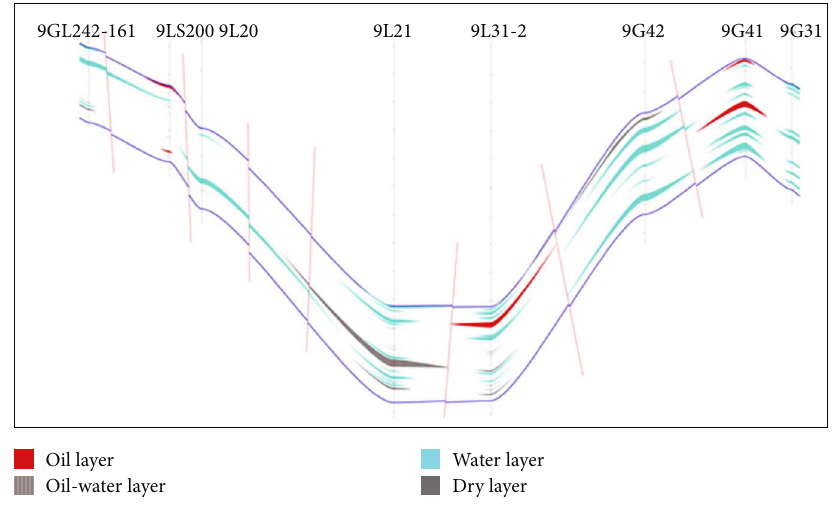
Figure 6: 9GL242-161 — 9G31well reservoir pro fi le.